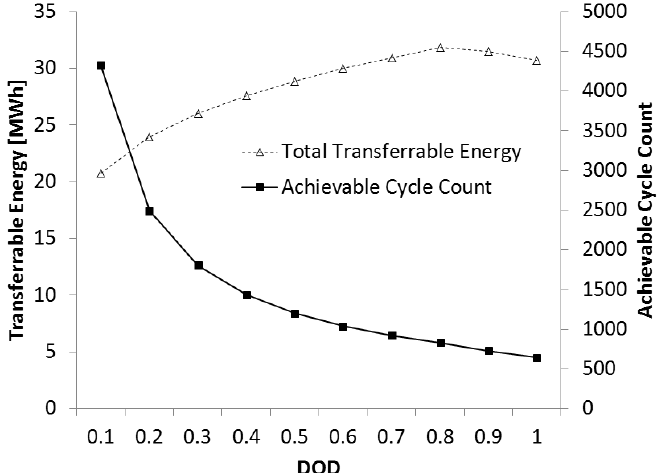
Figure 3. Achievable Cycle Count and Total Transferrable Energy with respect to